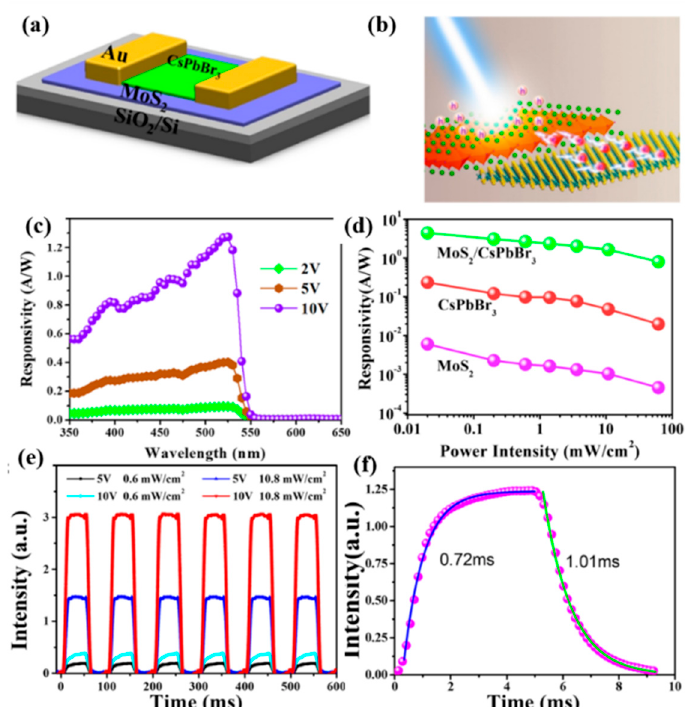
Figure 8. ( a ) The schematic diagram of the hybrid MoS 2 / CsPbBr 3 PDs. ( b ) The schematic diagram of the charge transfer from CsPbBr 3 to MoS 2 under illumination. ( c ) Photoresponsivity spectra of the hybrid MoS 2 / CsPbBr 3 PDs with di ff erent applied bias of 2, 5, and 10 V. ( d ) Photoresponsivity of the three PDs as a function of the power intensity. ( e ) Cyclic response of the hybrid MoS 2 / CsPbBr 3 PDs at di ff erent voltages and incident optical power intensity under 442 nm laser illumination. ( f ) The temporal photocurrent response of the hybrid PDs with rising time (0.72 ms) and decay time (1.01 ms), respectively [108].